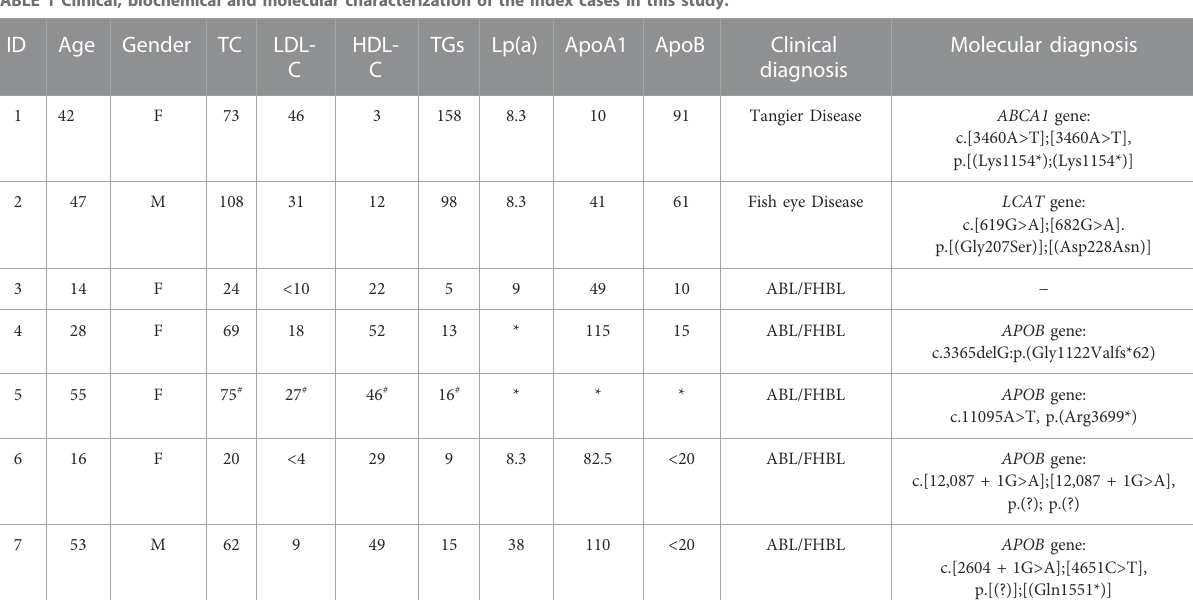
TABLE 1 Clinical, biochemical and molecular characterization of the index cases in this